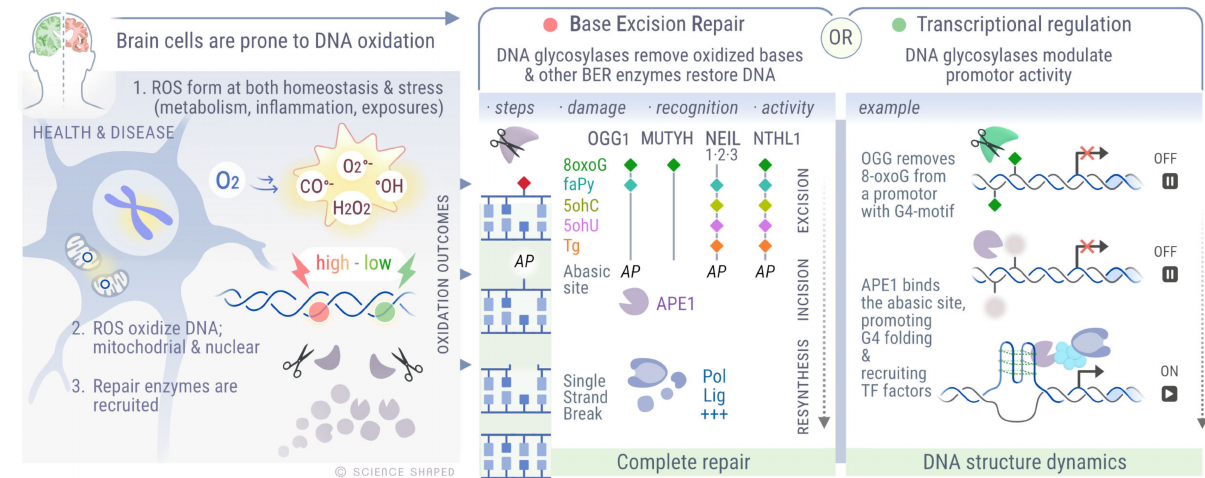
Figure 1. Outcomes of DNA oxidation in the brain mediated by endogenous levels of reactive oxygen species. ROS play key roles in brain homeostasis. However, at higher levels, ROS induce stress, culminating in the development of diseases (left panel). To counteract the harmful effects of ROS-induced DNA lesions, DNA glycosylases eliminate oxidized bases from DNA, restoring genomic integrity (middle panel). On the other hand, ROS-mediated base oxidation can also serve as a modulator of transcription in specific sequence contexts. For example, in G-forming quadruplex sequences, removal of 8-oxoG by OGG1 leads to the recruitment of APE1 , which promotes the folding of G4 structures in promoter regions and facilitates the loading of transcription factors, thereby modulating gene expression (right